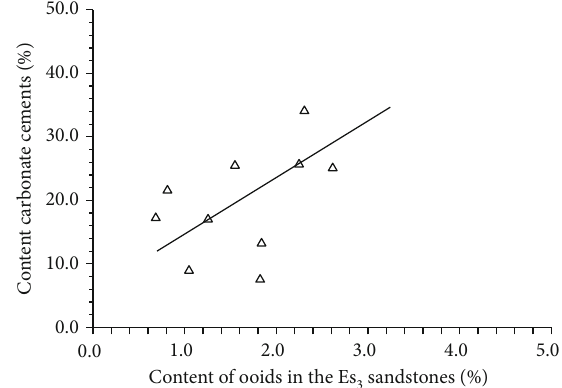
Figure 14: Relationship between content of carbonate cements and content of ooids in the Eocene Es 3